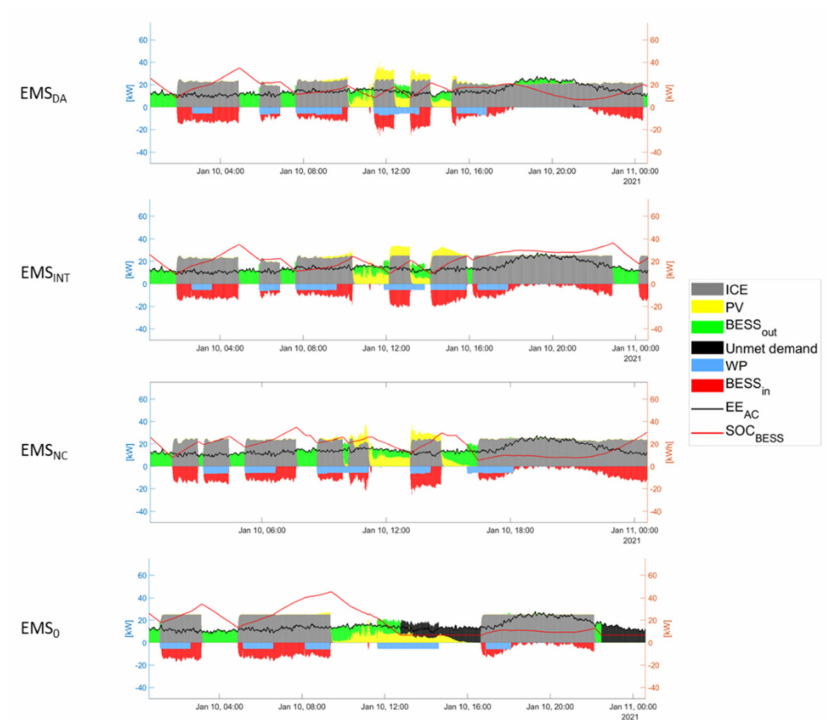
Figure 13. Microgrid dispatch comparison—day 3 (EMS NC reflects the actual microgrid operation while the others are simulation results).